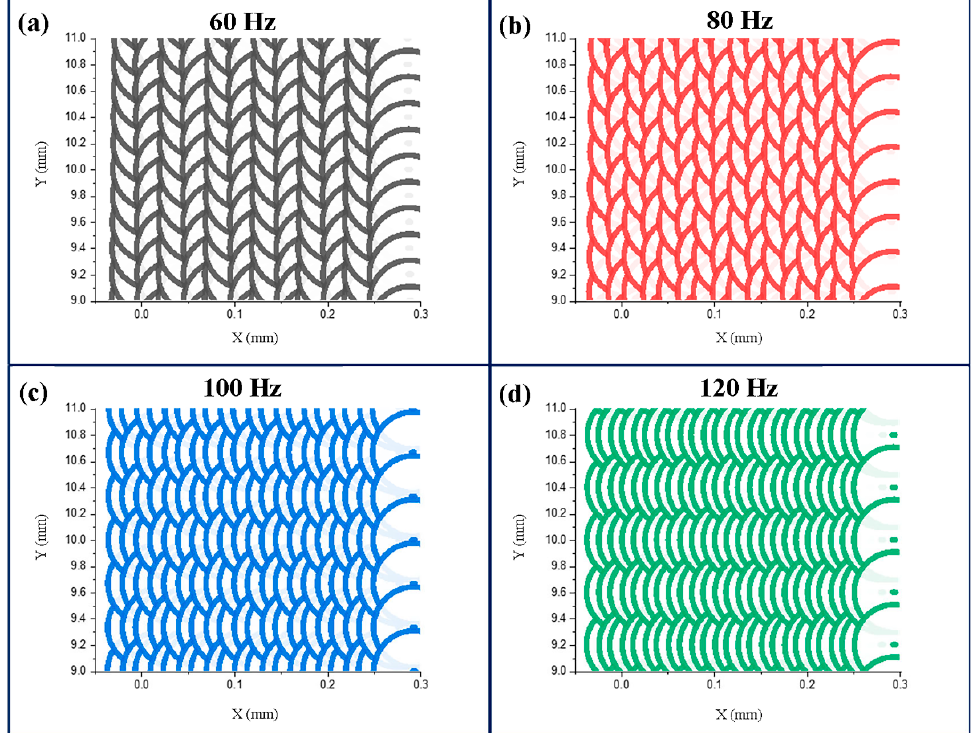
Figure 11. Pulsed laser spot distributions at different scanning frequencies: ( a ) 60 Hz, ( b ) 80 Hz, ( c ) 100 Hz, ( d ) 120